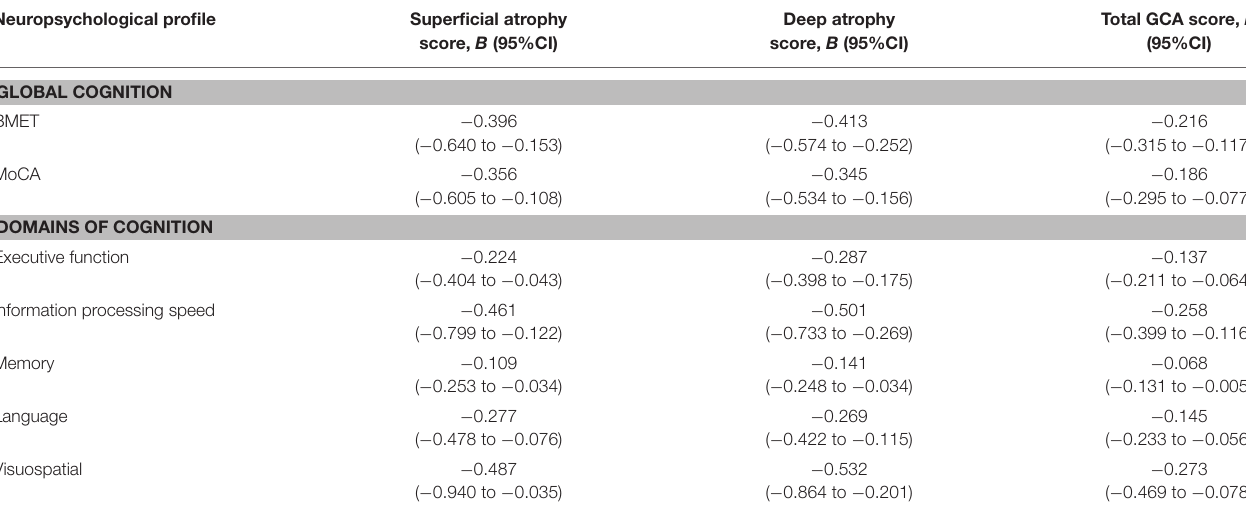
TABLE 4 | The association of the GCA score and cognitive performance in patients with CADASIL. Neuropsychological